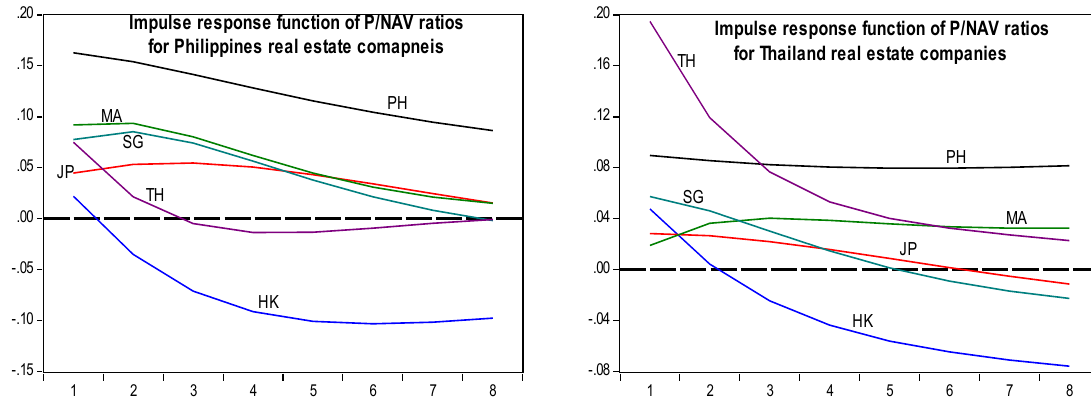
Figure 2. Generalized impulse response for Asia real estate stock markets, P /NAV ratios, eight-quarter forecast horizon, 2004Q1 to 2014Q4.